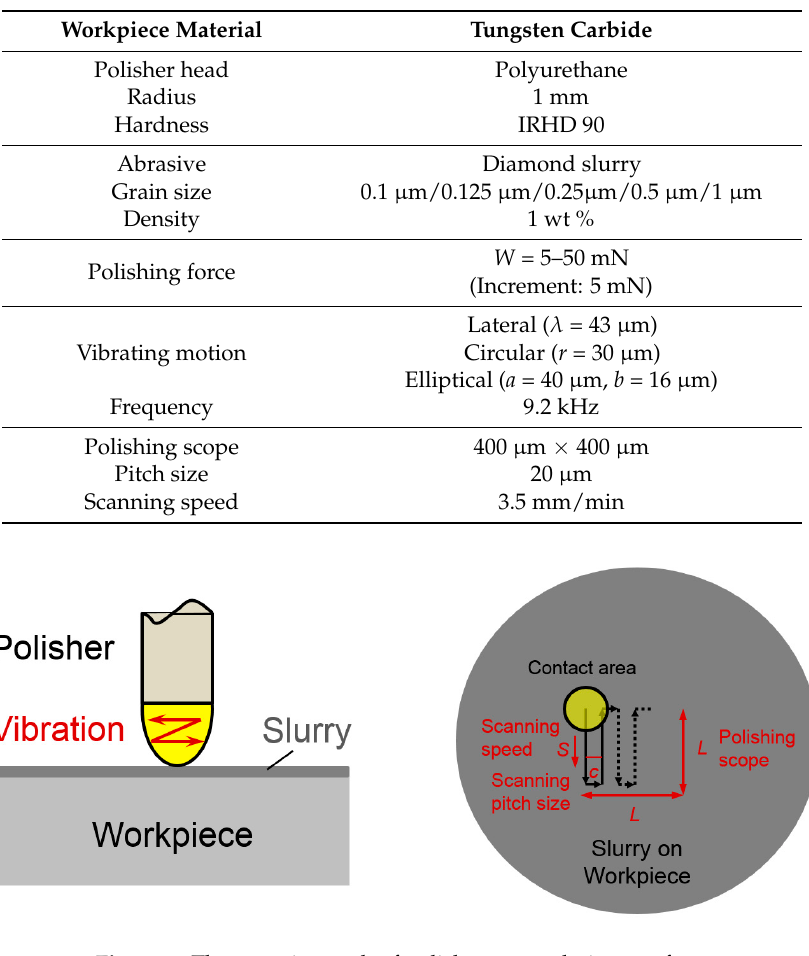
Figure 1. The scanning path of polisher on workpiece surface.